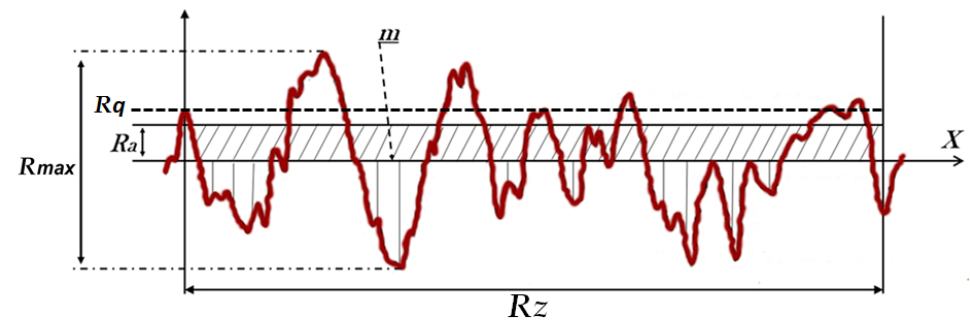
Figure 2. Scheme of the measured roughness parameters from the samples of each group.